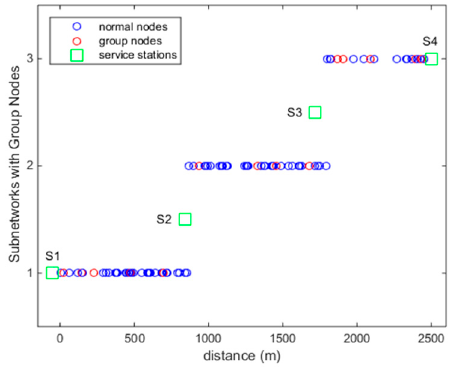
Figure 3. Subnetworks partition and grouping of group nodes.